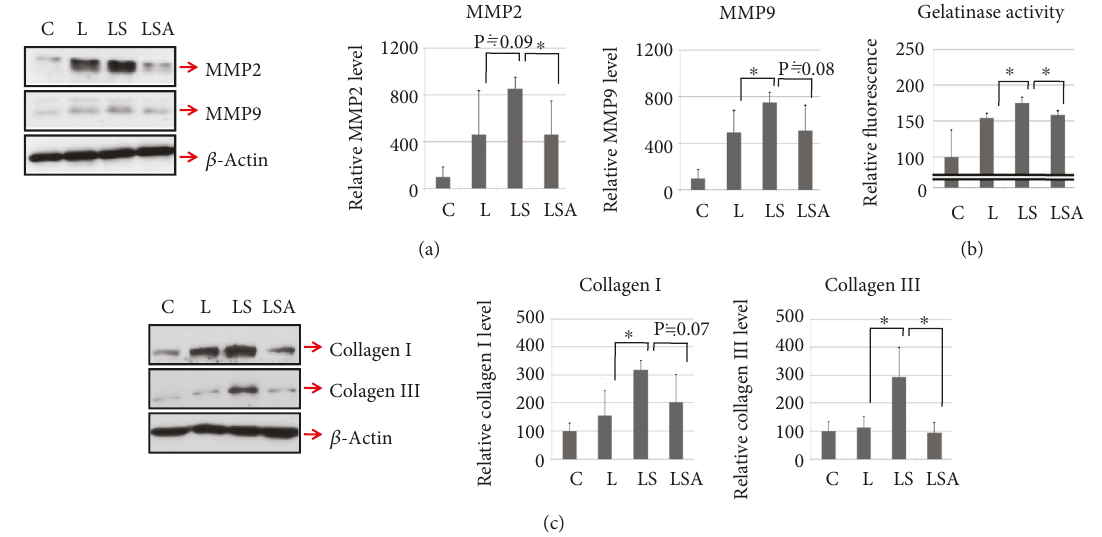
Figure 5: Cardiac matrix metalloproteinase and fi brotic factors are highly expressed in heart tissue from sesn2 knockdown mice after LPS treatment. (a) The levels of cardiac MMP2 and MMP9 were analyzed by Western blotting. (b) Cardiac gelatinase activity was measured using Gelatinase Assay Kit. (c) Fibrotic factors (collagen type I and collagen type III) were determined by Western blotting. (C: control mice; L: LPS only-treated mice; LS: sesn2 siRNA plus LPS-treated mice; LSA: sesn2 siRNA plus LPS and AICAR-treated mice). Data are presented as means; error bars represent ± SD ( ∗ P < 0 05 ;